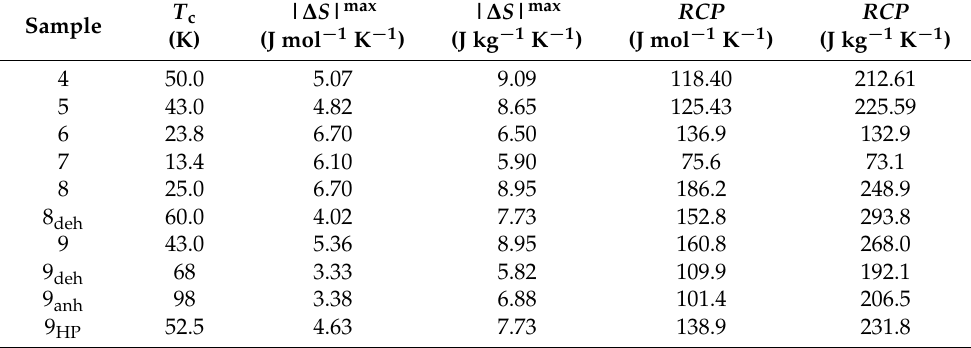
Figure 25. Temperature dependence of the magnetic entropy change of as-synthetized sample 9 ( p = 0 GPa) (empty symbols) and 9 under pressure p = 1.19 GPa (filled symbols) determined for μ 0 Δ H = 1, 3 and 5 T. Table 4 Comparison of MCE data obtained for samples discussed in Section 3 . | Δ S | max and RCP were Table 4. Comparison of MCE data obtained for samples discussed in Section 3. | ∆ S | max and RCP determined for μ 0 Δ H =5 T; MCE: magnetocaloric effect; RCP: relative cooling power were determined for µ 0 ∆ H = 5 T; MCE: magnetocaloric effect; RCP: relative cooling power